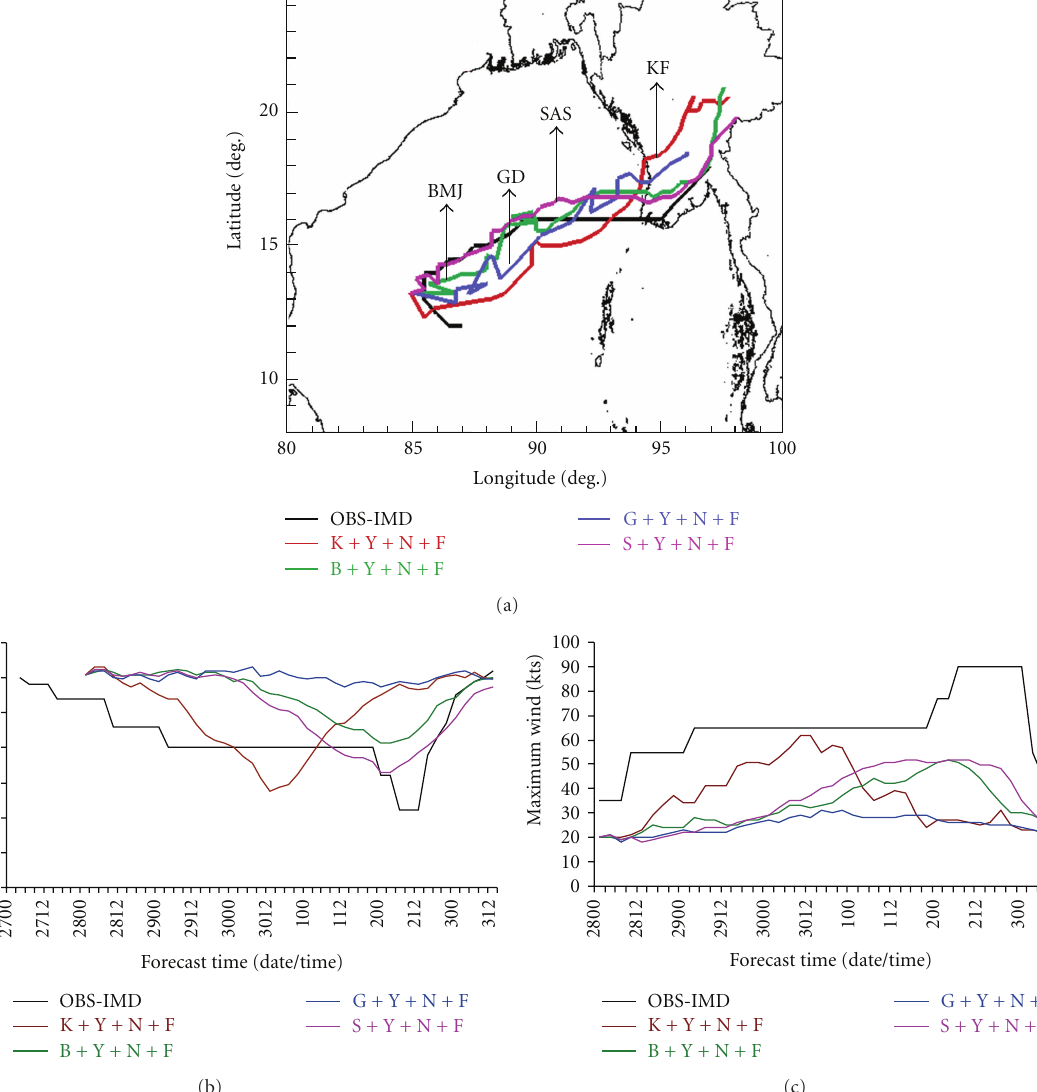
Figure 1: (a) Track of the cyclone Nargis, (b) MSLP (hPa), and (c) maximum wind (kts) with 4 di ff erent cumulus convective schemes, YSU PBL, NMM land surface, and Ferrier microphysics